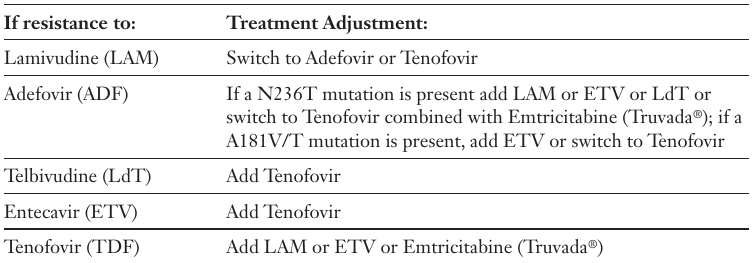
Treatment of special patients groups